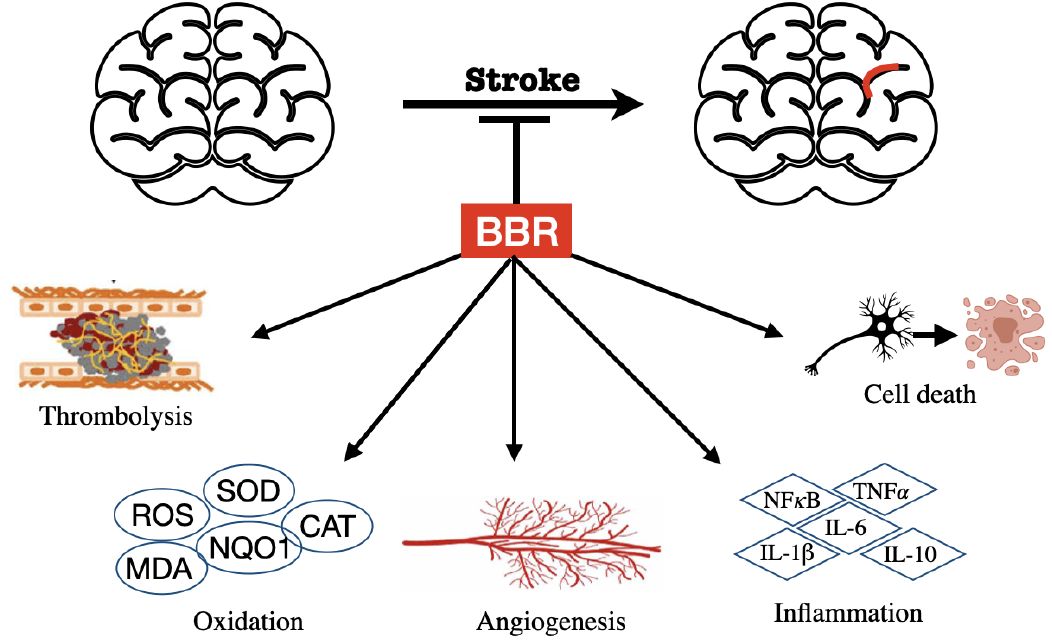
Figure 3. Effects of BBR against stroke.